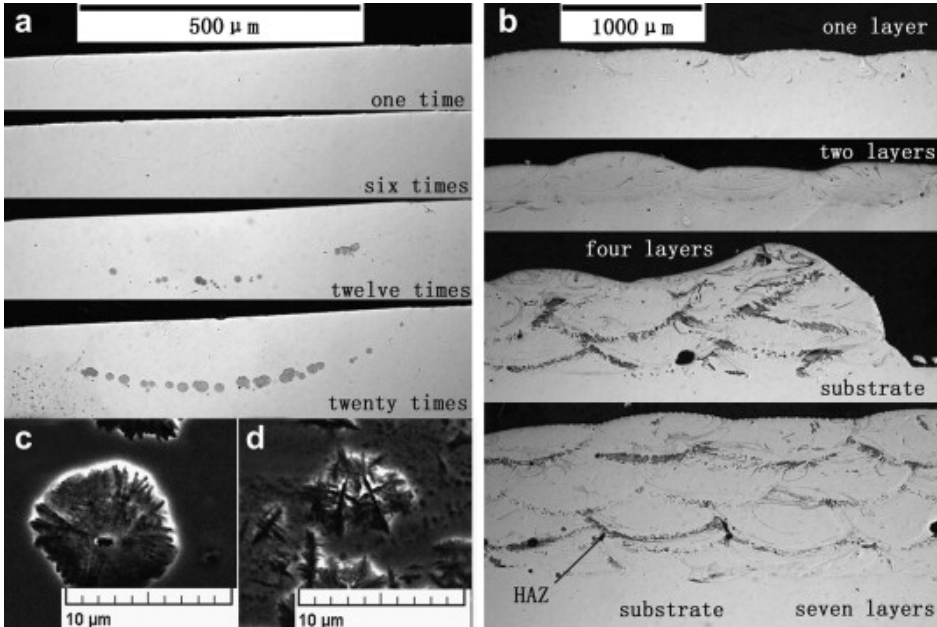
Figure 29. ( a ) Cross-sections of a Zr-based BMG as a result of one, six, twelve, and twenty laser pulses, ( b ) cross-section of one, two, four, and seven deposited layers using LSF, ( c ) spherulite crystal in the HAZ of the sample with twenty pulses, and ( d ) crystals in the HAZ of the sample with seven deposited layers. Reproduced from [91], with permission from Elsevier, 2021.